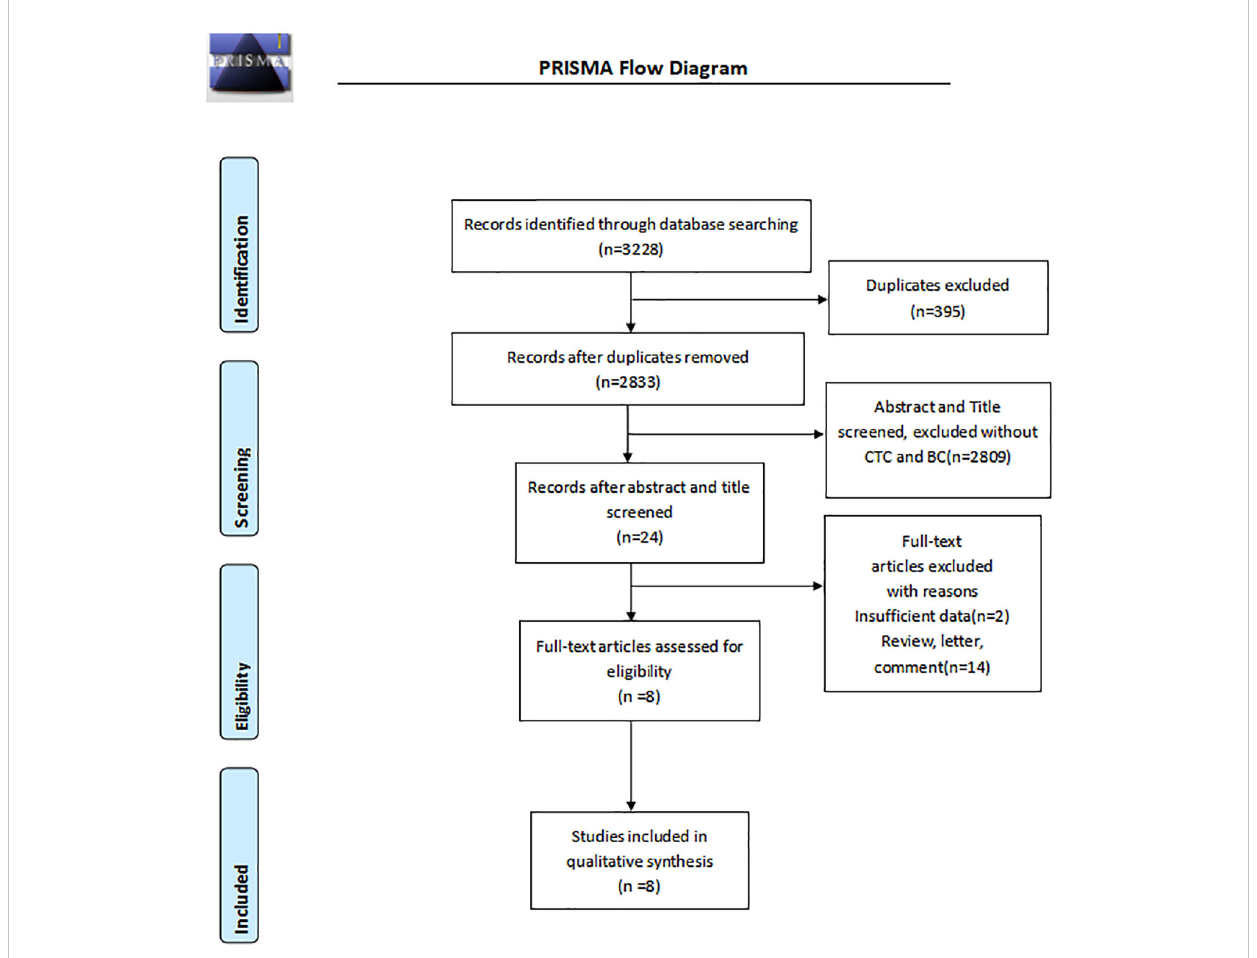
FIGURE 1 A fl ow chart of the search and selection of relevant